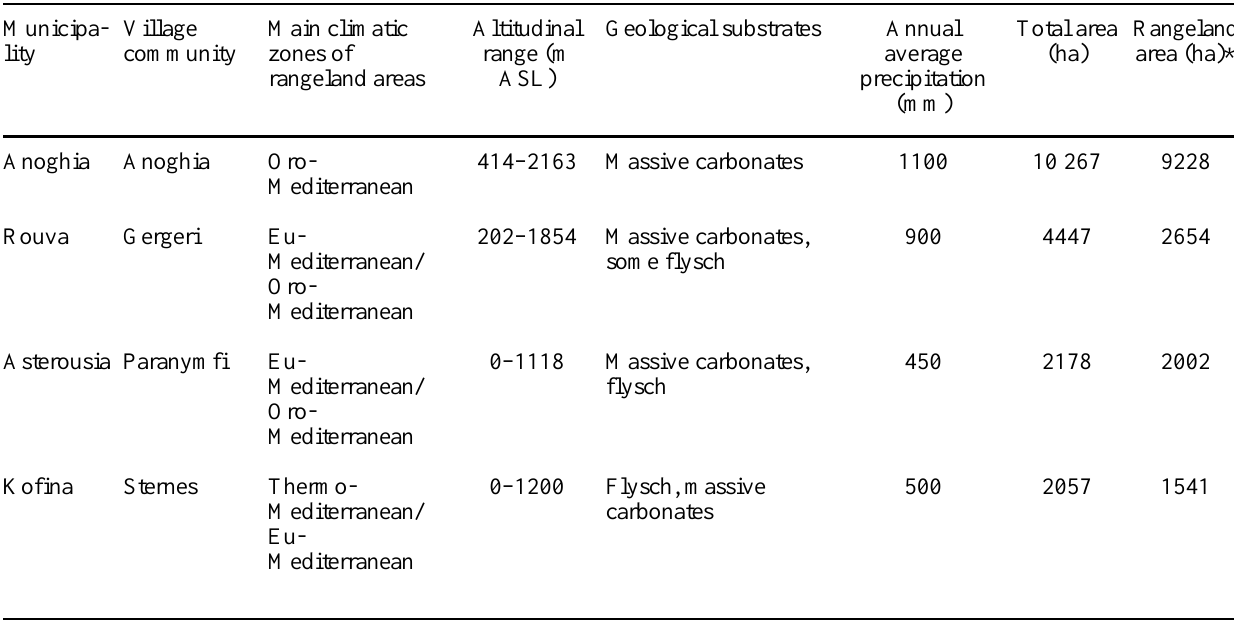
Table 1. Biophysical attributes of the surveyed municipalities. Municipa-